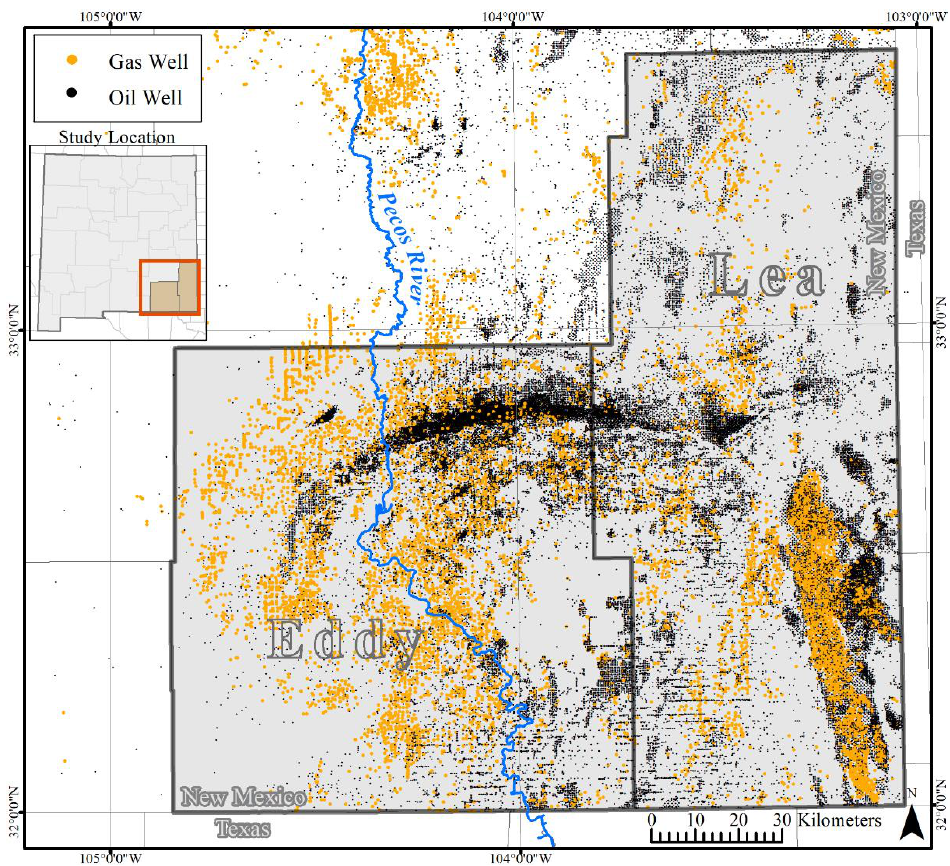
Figure 2. Study area map illustrating the distribution of oil and gas wells.